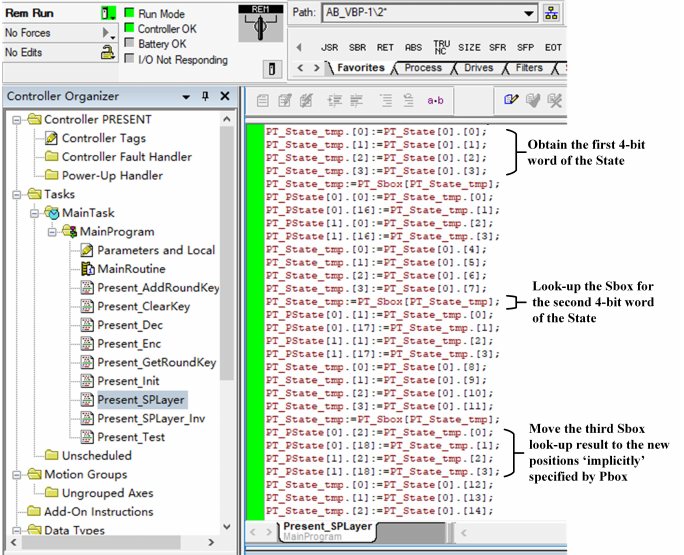
Figure 4: Code Snippet of the Hard-coded SBOXLayer and PBOXLayer of